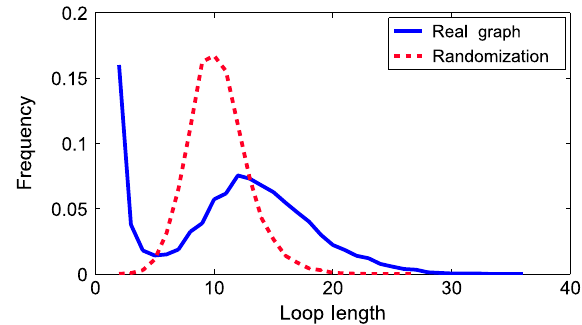
FIG. 3. Distribution of definitional loops in the dictionary. The data represent counts of links in the core indexed by the shortest loop in which they appear. For the randomization, links are randomly redrawn between nodes while keeping the in-degree and out-degree distributions of the graph